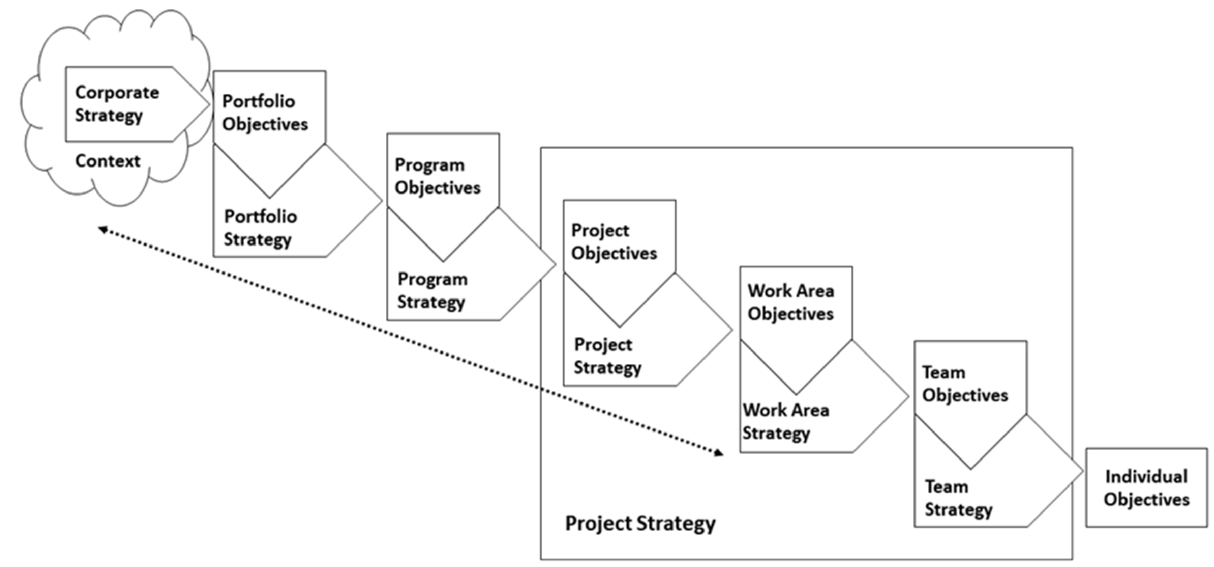
Figure 1. The cascading objectives (Turner, 2009: page